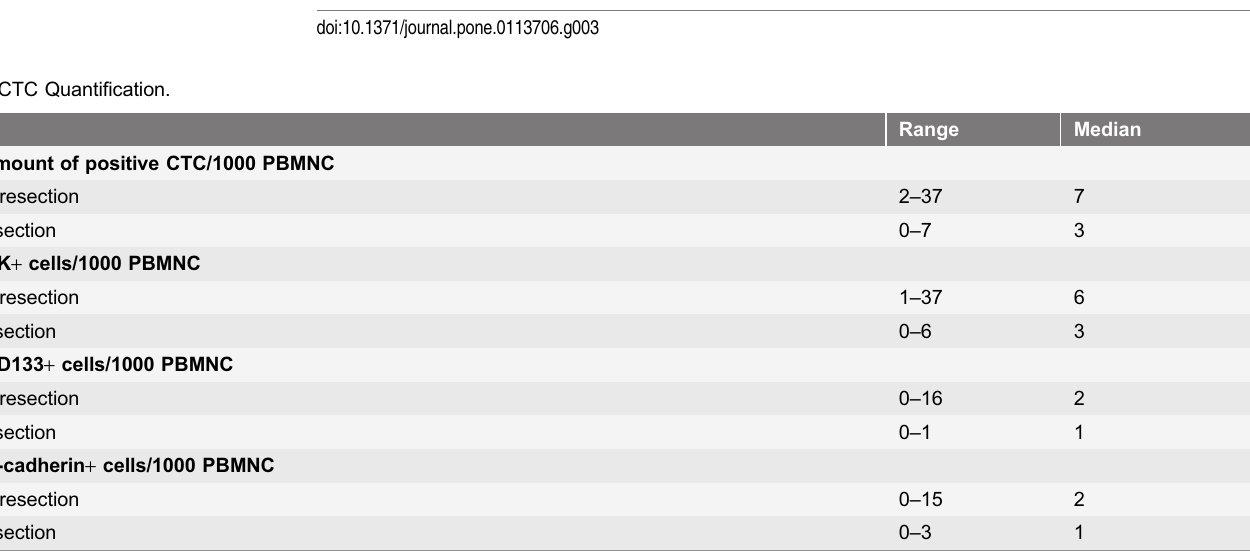
Figure 3. Subtype analysis revealed a significant decrease of epithelial CK + , mesenchymal N- cadherin + and stem cell-like CD133 + cells after resection. A ) Wilcoxon test showed that the total amount of CTC/1000 PBMNC was significantly decreased after resection (p 5 0.002). CTC-Subtype analyses revealed that the total amount of epithelial (CK-positive; B ), mesenchymal (N-cadherin-positive; C ) and stem cell-like (CD133-positive; D ) CTC, respectively, was significantly decreased after resection.